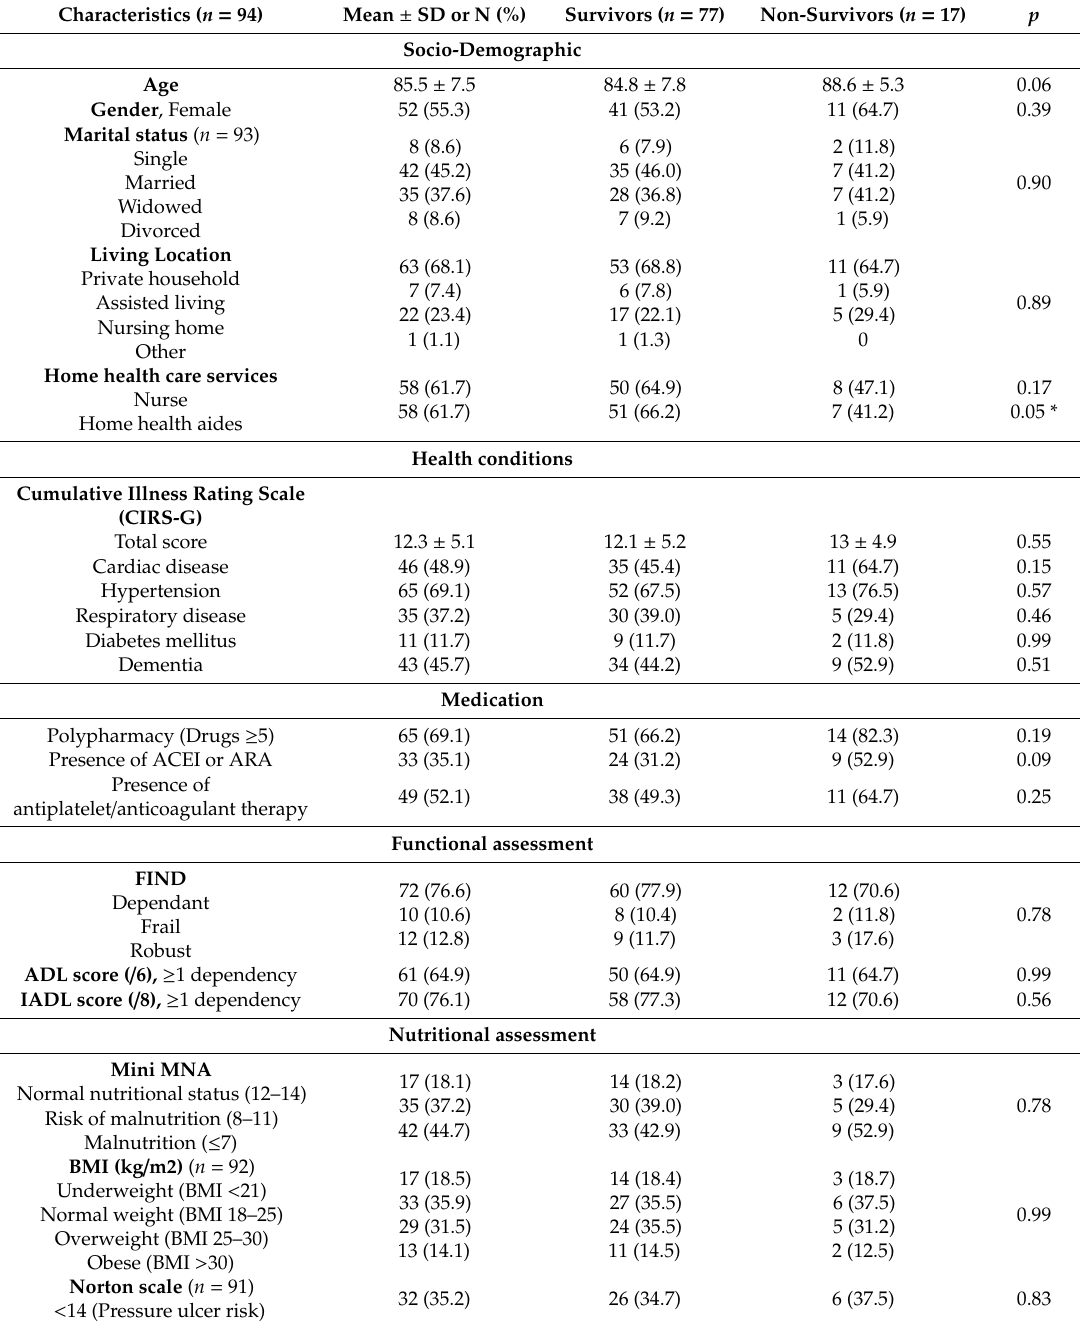
Table 1. Baseline characteristics of older patients with